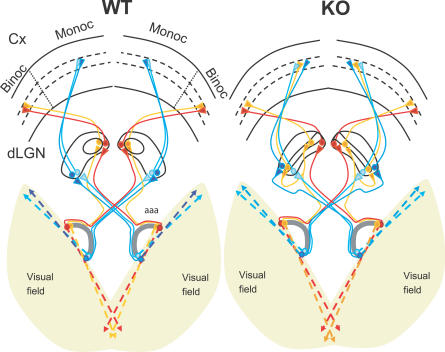
Schematic Diagram Summarising Observed Changes in Visual Circuitry in Ten_m3 KOsIn WT mice (left), ipsilateral retinal fibres (orange) project exclusively to the dorsomedial dLGN. Contralaterally projecting RGCs, which view similar regions of the central, binocular region of the field (red), also project to the dorsal (binocular) region of the dLGN. Contralaterally projecting fibres from more nasal retina receive inputs from the peripheral, monocular region of the visual field and project to more ventral dLGN (blue fibres). The dLGN projects topographically to visual cortex with dorsal (binocular) dLGN represented laterally (binocular region of area 17) and ventral dLGN represented more medially (monocular region). Thus, there is a continuous representation of the contralateral visual field across the visual cortex. Note that nearby regions of visual space map to nearby regions of visual cortex, creating a single, cohesive map of the visual world. In Ten_m3 KO mice, the contralateral inputs map to dLGN similarly as described for WTs. Ipsilateral fibres map aberrantly along the DM-VL axis of the dLGN. The topographic relationship between thalamus and cortex is maintained, however. Therefore, ipsilateral inputs that project to ventral regions of the dLGN (normally the monocular segment) are transferred to more medial (normally monocular) region of area 17. Consequently, cells in area 17 that normally receive inputs only from nearby regions of the monocular visual field will now receive inputs from widely disparate regions of the monocular and binocular fields. Thus the cohesive map of visual space in the cortex is disrupted due to the mistargeting of ipsilateral projections to the dLGN. This leads to an interocular mismatch of the inputs to area 17 in Ten_m3 KOs.